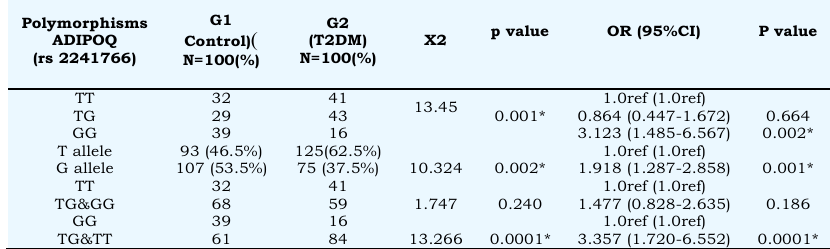
Table 3 The genotypes and allele distribution of ADIPOQ (rs 2241766) polymorphism in G1 (Control) and G2